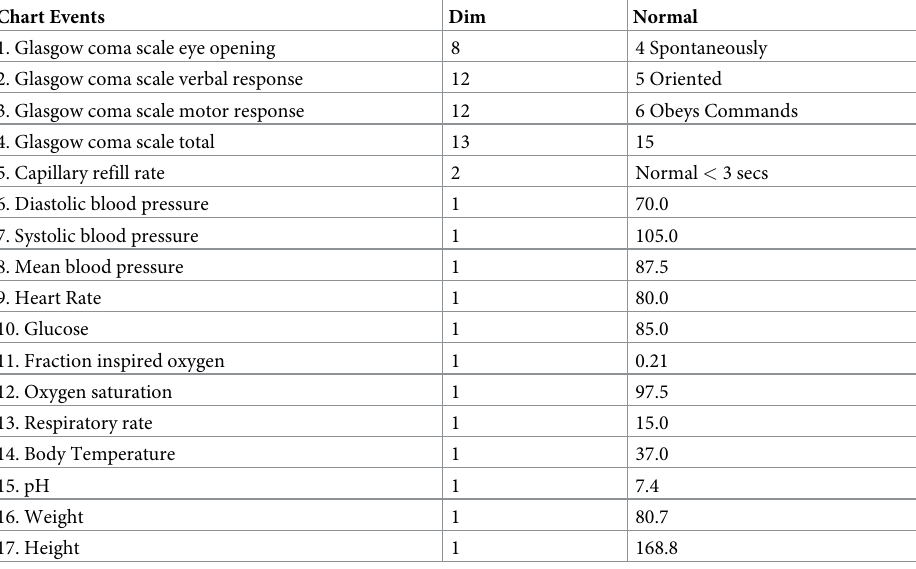
Table 1. 17 Types of features in the chart